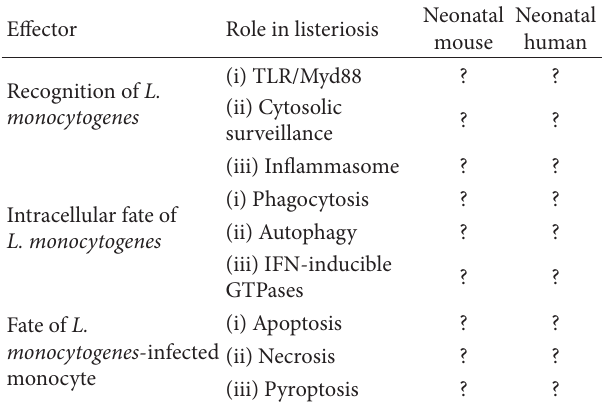
Table 2: Age-dependent differences in cell autonomous immunity to L.